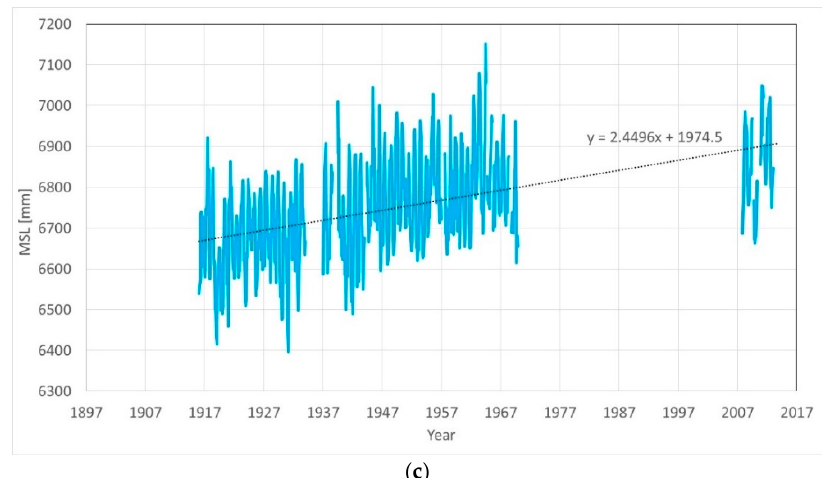
Figure 12. MSL of Fremantle with the same gaps as Aden. ( a ) The effect of the gaps. ( b ) Breakpoints alignment. ( c ) Aligned series with gaps.